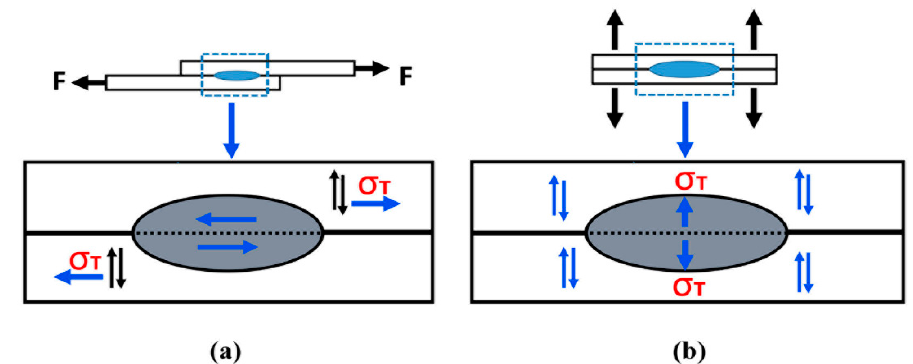
Figure 6. Stress distribution at the interface of two blanks and circumference of a weld nugget: ( a ) tensile shear test; ( b ) cross-tension tests.